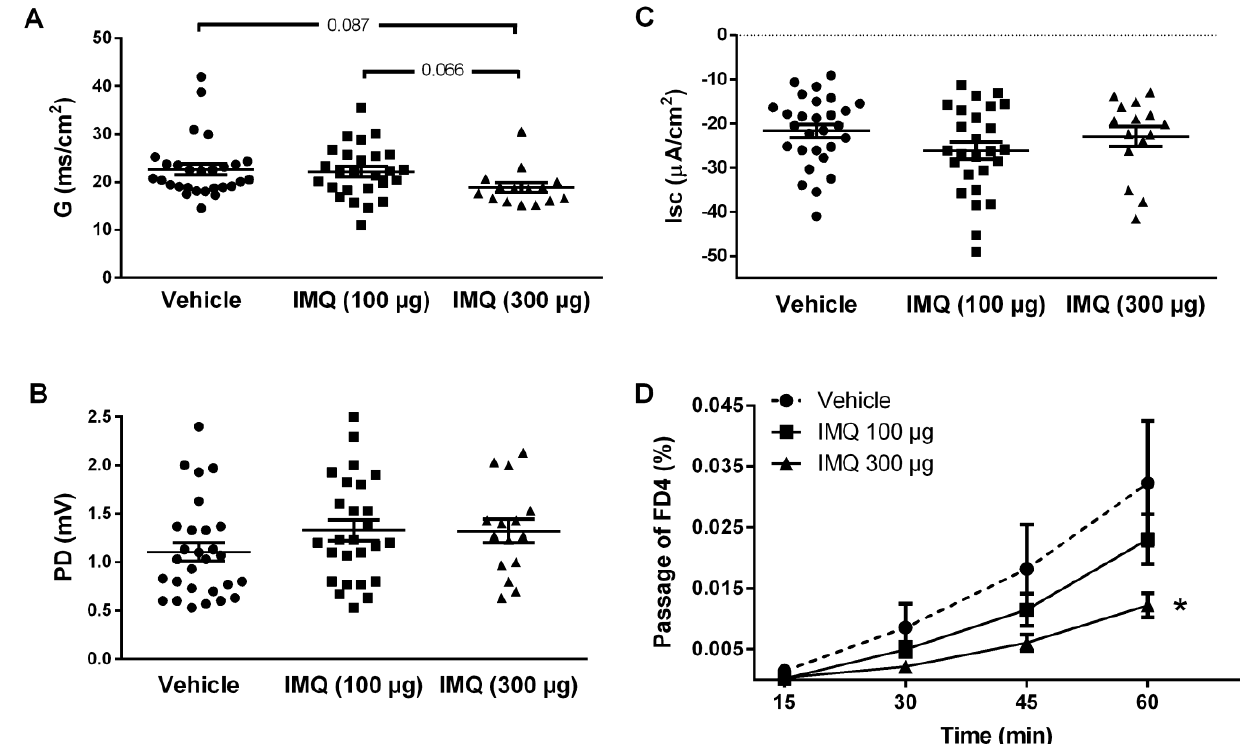
Figure 2. Effects of pre-exposure to imiquimod (IMQ) (intracolonic) on the colonic epithelial electrical parameters and permeability to macromolecules. ( A – C ) Epithelial electrical parameters: conductance (G, panel A ), potential difference (PD, panel B ) and short circuit current (I sc , panel C ). Each point represents a colonic sheet, and the horizontal line with errors shows the mean ± SEM ( n = 15–28 colonic sheets from 9–16 animals per group). ( D ) Effects of imiquimod on epithelial permeability to macromolecules. The graph shows the mucosal to basolateral passage (as percentage of the amount added to the mucosal reservoir) of fluorescein isothiocyanate-dextran 4 kD (FD4) in control conditions (vehicle pre-treatment) and in tissues pre-exposed to imiquimod. Data are the mean ± SEM, n = 6–12 colonic sheets from 3 – 6 animals per group. *: p < 0.05 vs. Vehicle.